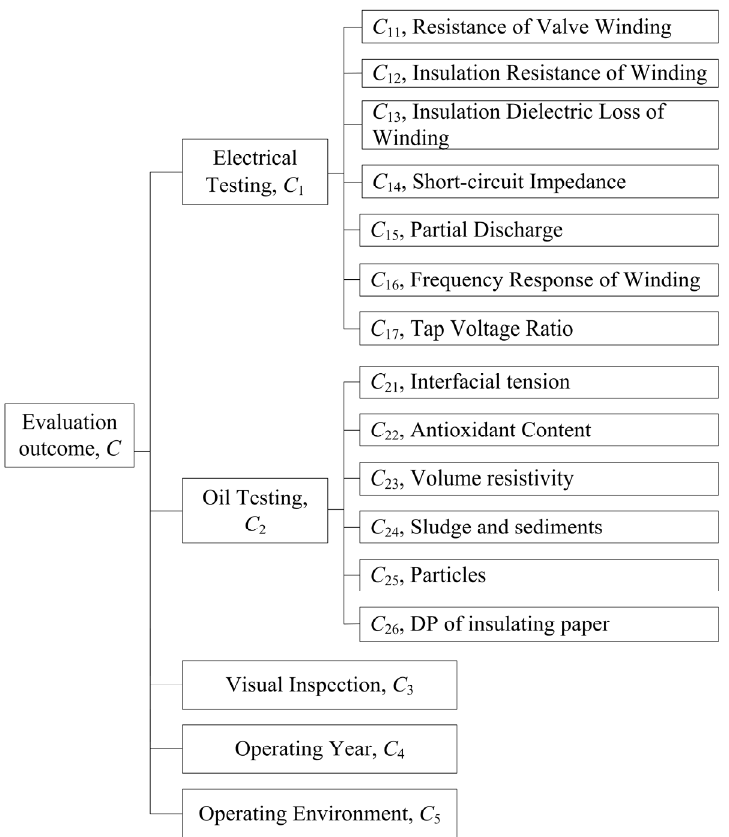
Figure 2. Level 2 assessing index system.